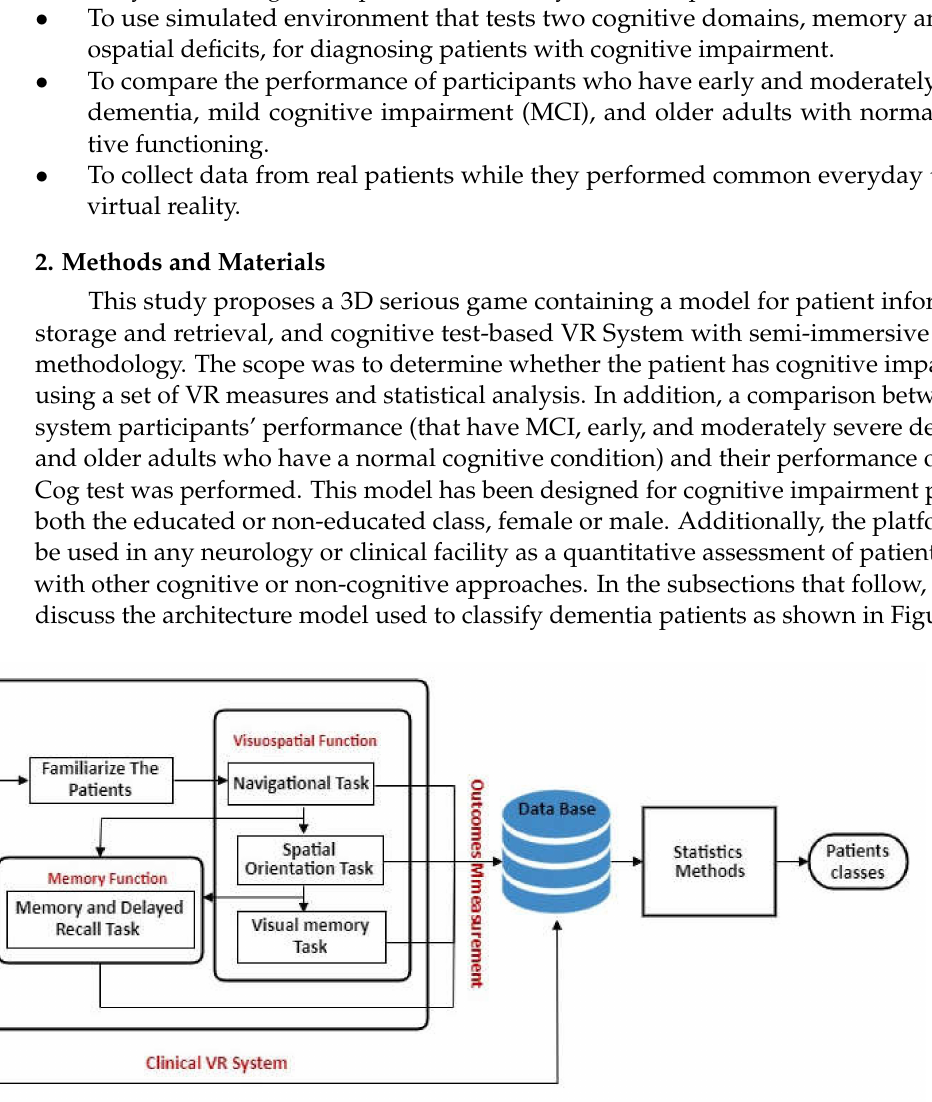
Figure 2. Architecture model of diagnosis dementia